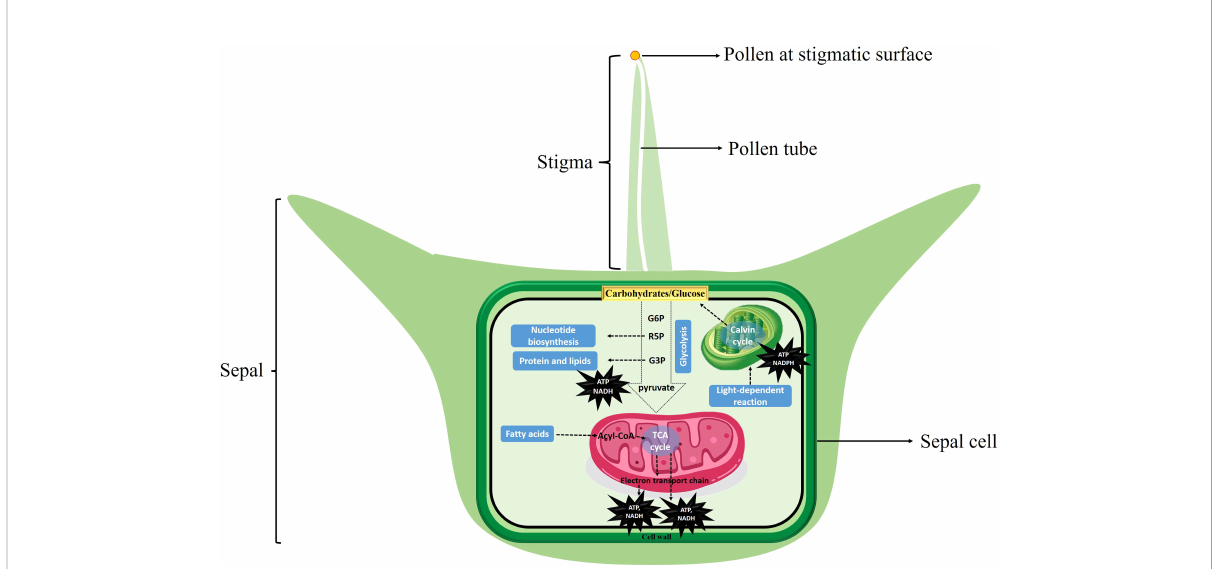
FIGURE 8 Energy metabolic model regulating sepal development in spinach. Carbohydrates serve as cell fuel for post-pollination sepal development: glucose and other sugar molecules are broken down by controlled cellular respiration (glycolysis, TCA process, oxidative phosphorylation) and fermentation to supply energy in the form of ATP, reduction power and intermediates (nucleic acid, proteins, and lipids) for biomass accumulation to the sepal cells for